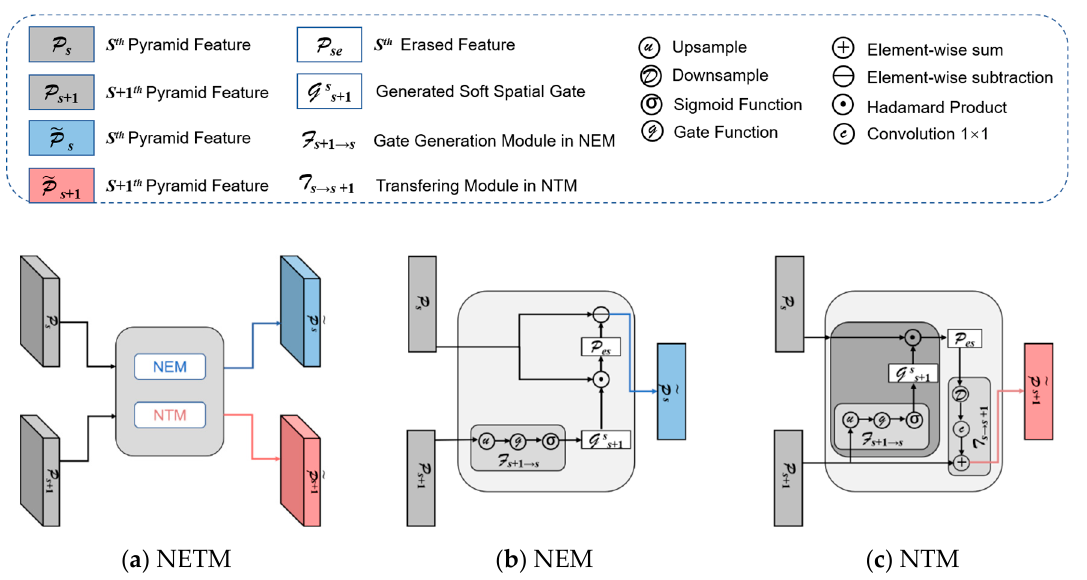
Figure 5. Sketch of the NETM. ( a ) Neighbor Erasing and Transferring Mechanism. ( b ) Neighbor Erasing Module. ( c ) Neighbor Erasing Module. The salient large object features erased by NEM are transferred to the deeper layer via NTM.